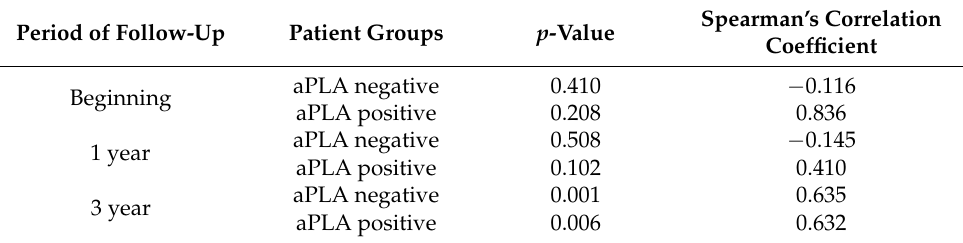
Spearman’s Correlation Coefficient